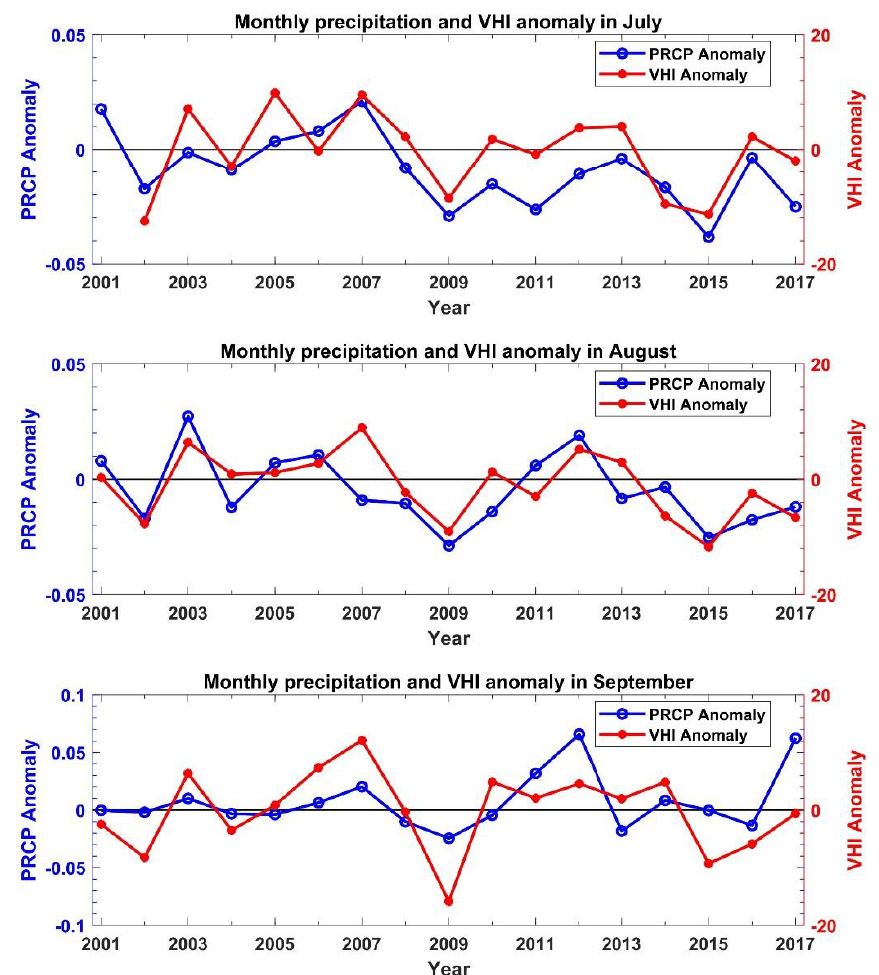
Figure 9. Monthly rainfall anomalies and VHI anomalies during the crop growing season. The trough points coincide with the timing of drought events and El Niño events.